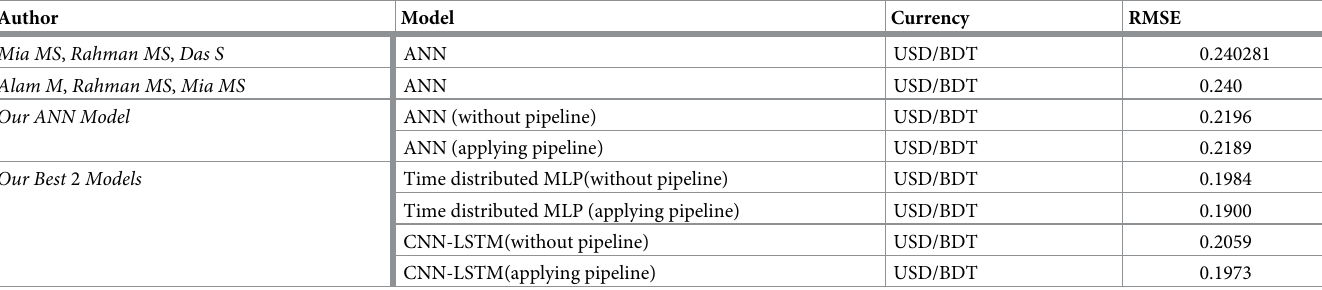
Table 5. Comparing other USD/BDT exchange rate article with our